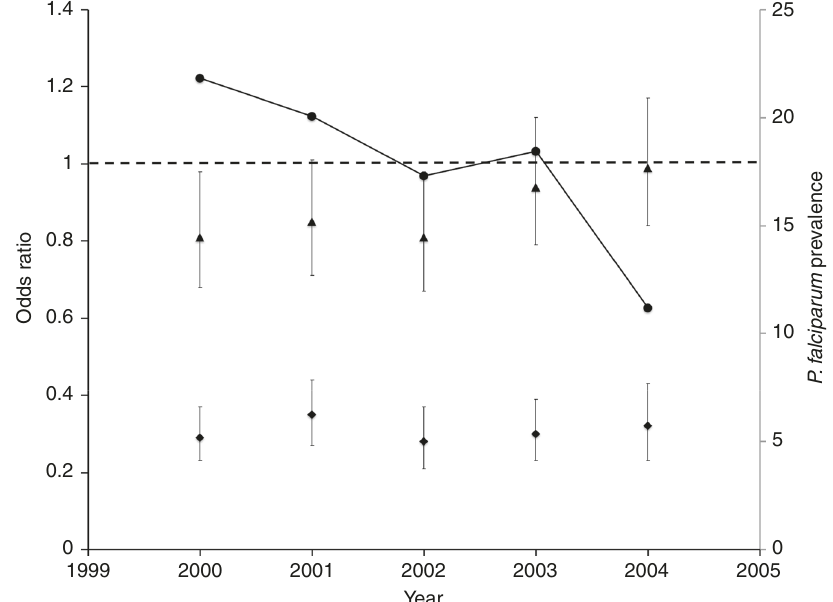
Fig. 2 The odds ratios for HbAS in cases versus community controls, strati fi ed by year of study. Triangles show the ORs for HbAS among patients admitted with a negative and diamonds for patients admitted with a positive blood slides for P. falciparum malaria parasites. Circles show the prevalence of P. falciparum parasite positivity among all admitted patients. The x -axis denotes each year of the study between 2000 and 2005. Horizontal dashed line denotes an OR of one: ORs below the line denote a protective effect of HbAS against the condition of interest. Error bars show 95% con fi dence intervals